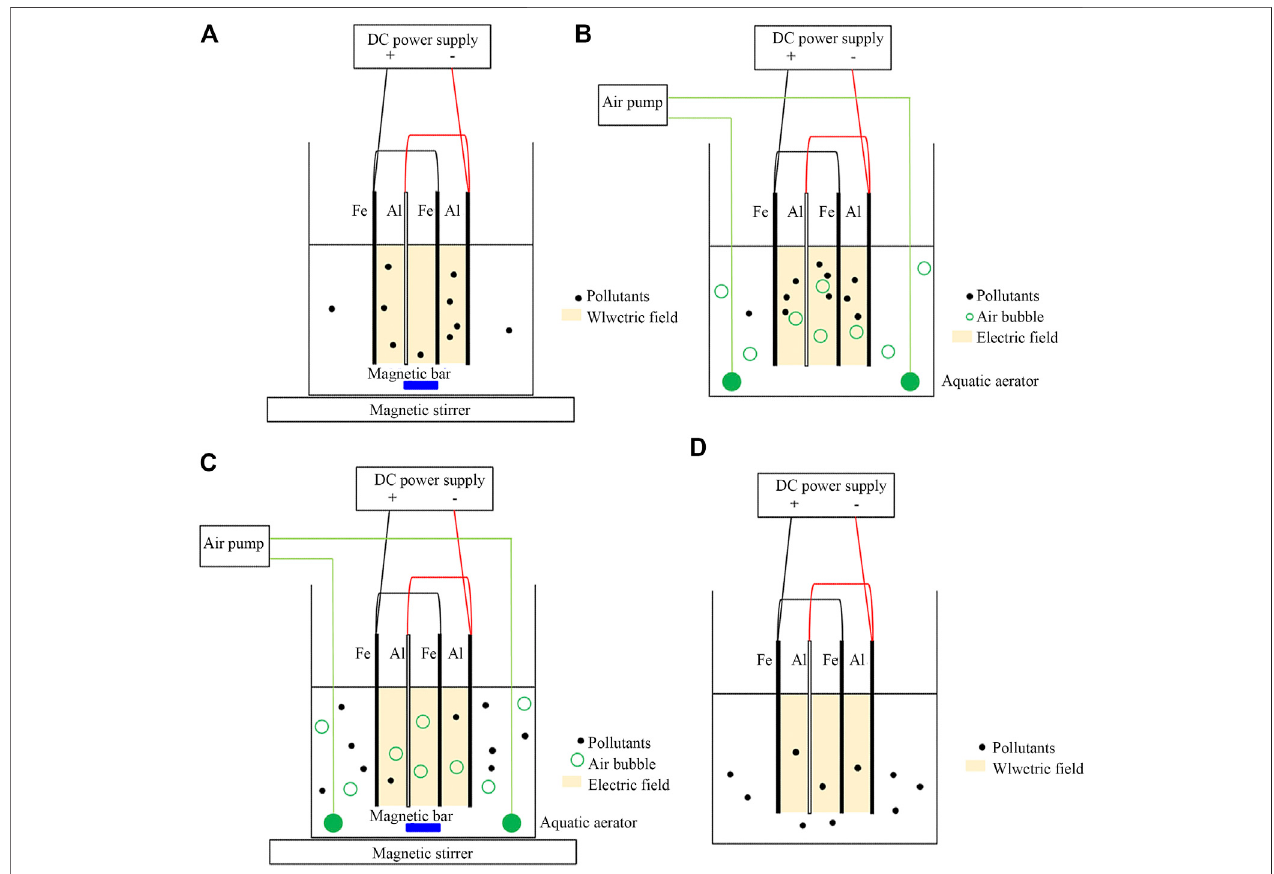
FIGURE 2 | Mechanisms occurred in different EC systems.